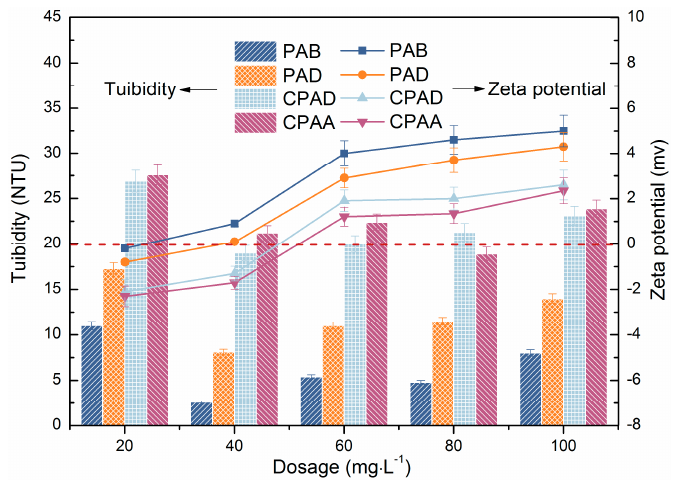
Figure 7. Effect of flocculants dosage on tuibidity and zeta potential of the sludge supernatant.